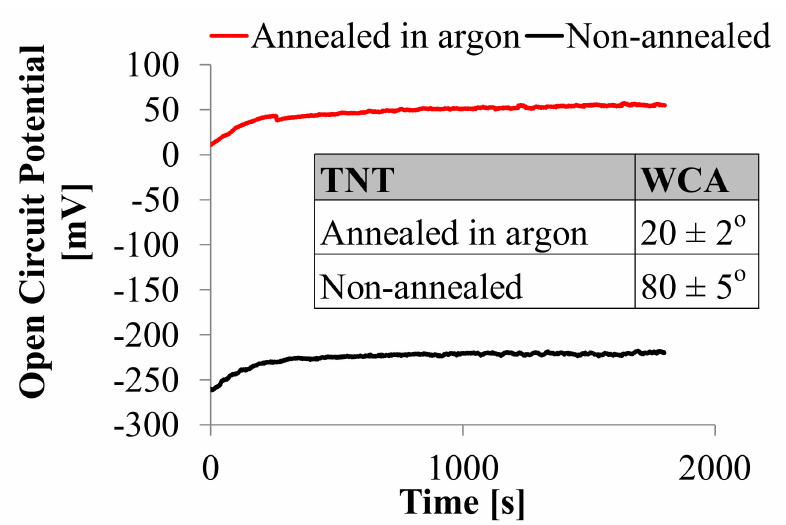
Figure 2. Water contact angle (WCA) and open circuit potential (OCP) measurements of TNT layers (diameter 50 ± 5 nm, 1000 ± 100 nm thickness) before and after annealing in argon in temperature 550 ◦ C for 2